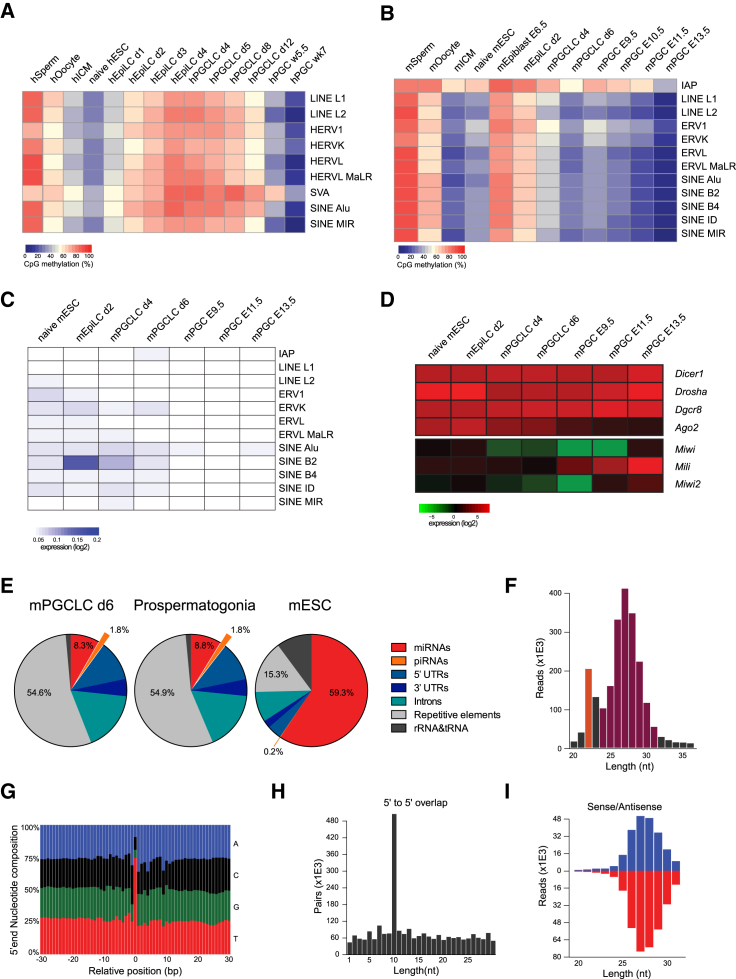
Methylation Dynamics and Transcriptional Regulation of Transposable Elements(A) Averaged CpG methylation of major human repetitive elements in human datasets.(B) Averaged CpG methylation of major murine repetitive elements in mouse datasets.(C) Averaged expression of major murine repetitive elements in mouse poly(A)-enriched RNA-seq datasets. Repeat locations were extracted from the pre-masked repeatmasker libraries and repeat instances within 2 kb of an annotated gene were removed.(D) Expression of key enzymes involved in smRNA biogenesis and function in mouse naive mESCs, primed day-2 mEpiLCs, mPGCLCs, and in vivo mPGCs. The heatmap shows the average expression (log2) of biological replicates.(E) Distribution of reads from smRNA-seq libraries from day-6 mPGLCLs, in vivo prospermatogonia, and mESCs over different classes of smRNAs as defined previously (Han et al., 2015, Li et al., 2013). smRNAs mapping to (gene-derived) piRNAs are highlighted.(F) Length distribution of all uniquely mapped smRNAs, excluding rRNAs, in day-6 mPGCLCs. The average length of miRNAs (22 nt) and piRNAs (24–31 nt) is highlighted.(G) Nucleotide composition of the 5′ ends ± 30 nt of all smRNAs from day-6 mPGCLCs uniquely mapped to repetitive elements (defined by repeatmasker).(H) Ping-pong (5′ to 5′ overlap) analysis of normalized reads from day-6 mPGCLCs mapped to repetitive elements (defined by repeatmasker).(I) Length distribution of smRNAs from day-6 mPGCLCs assigned to sense (blue) and antisense (red) strands of reads uniquely mapped to repetitive elements (defined by repeatmasker).Published datasets from human sperm, oocytes (Okae et al., 2014), ICM (Guo et al., 2014), naive ESCs (Takashima et al., 2014), in vivo PGCs (Tang et al., 2015), and mouse sperm, oocytes, ICM (Wang et al., 2014), naive ESCs (Ficz et al., 2013), epiblast, and in vivo PGCs (Seisenberger et al., 2012) were included in the analysis. Biological replicates were pooled and average levels were used for the analysis. See also Figure S4.